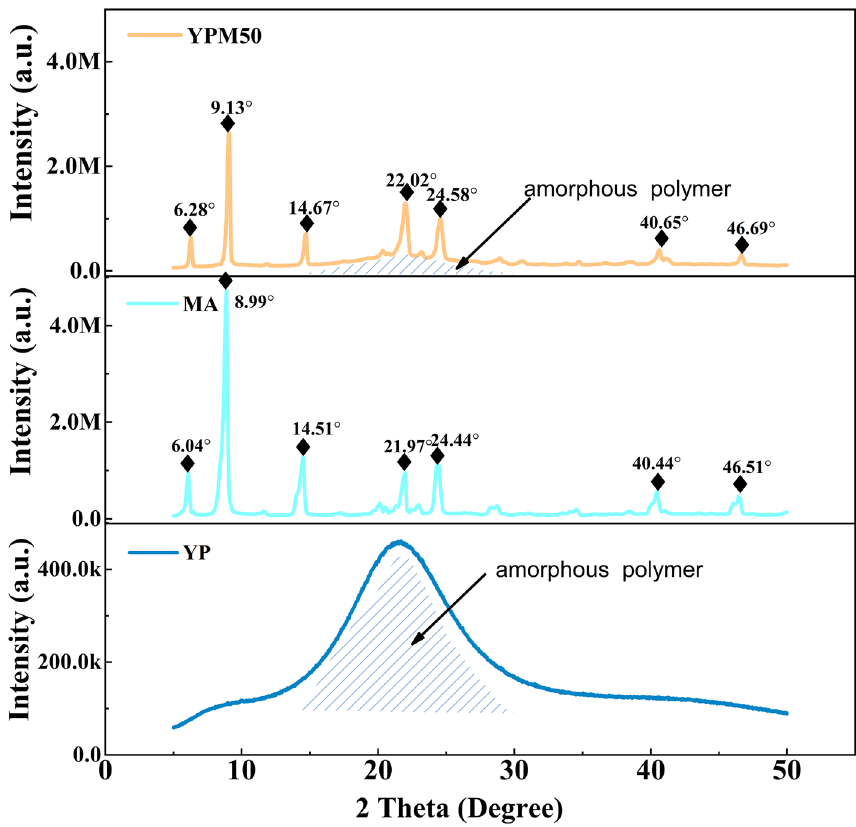
Figure 3. The XRD diffractogram of YP, MA and